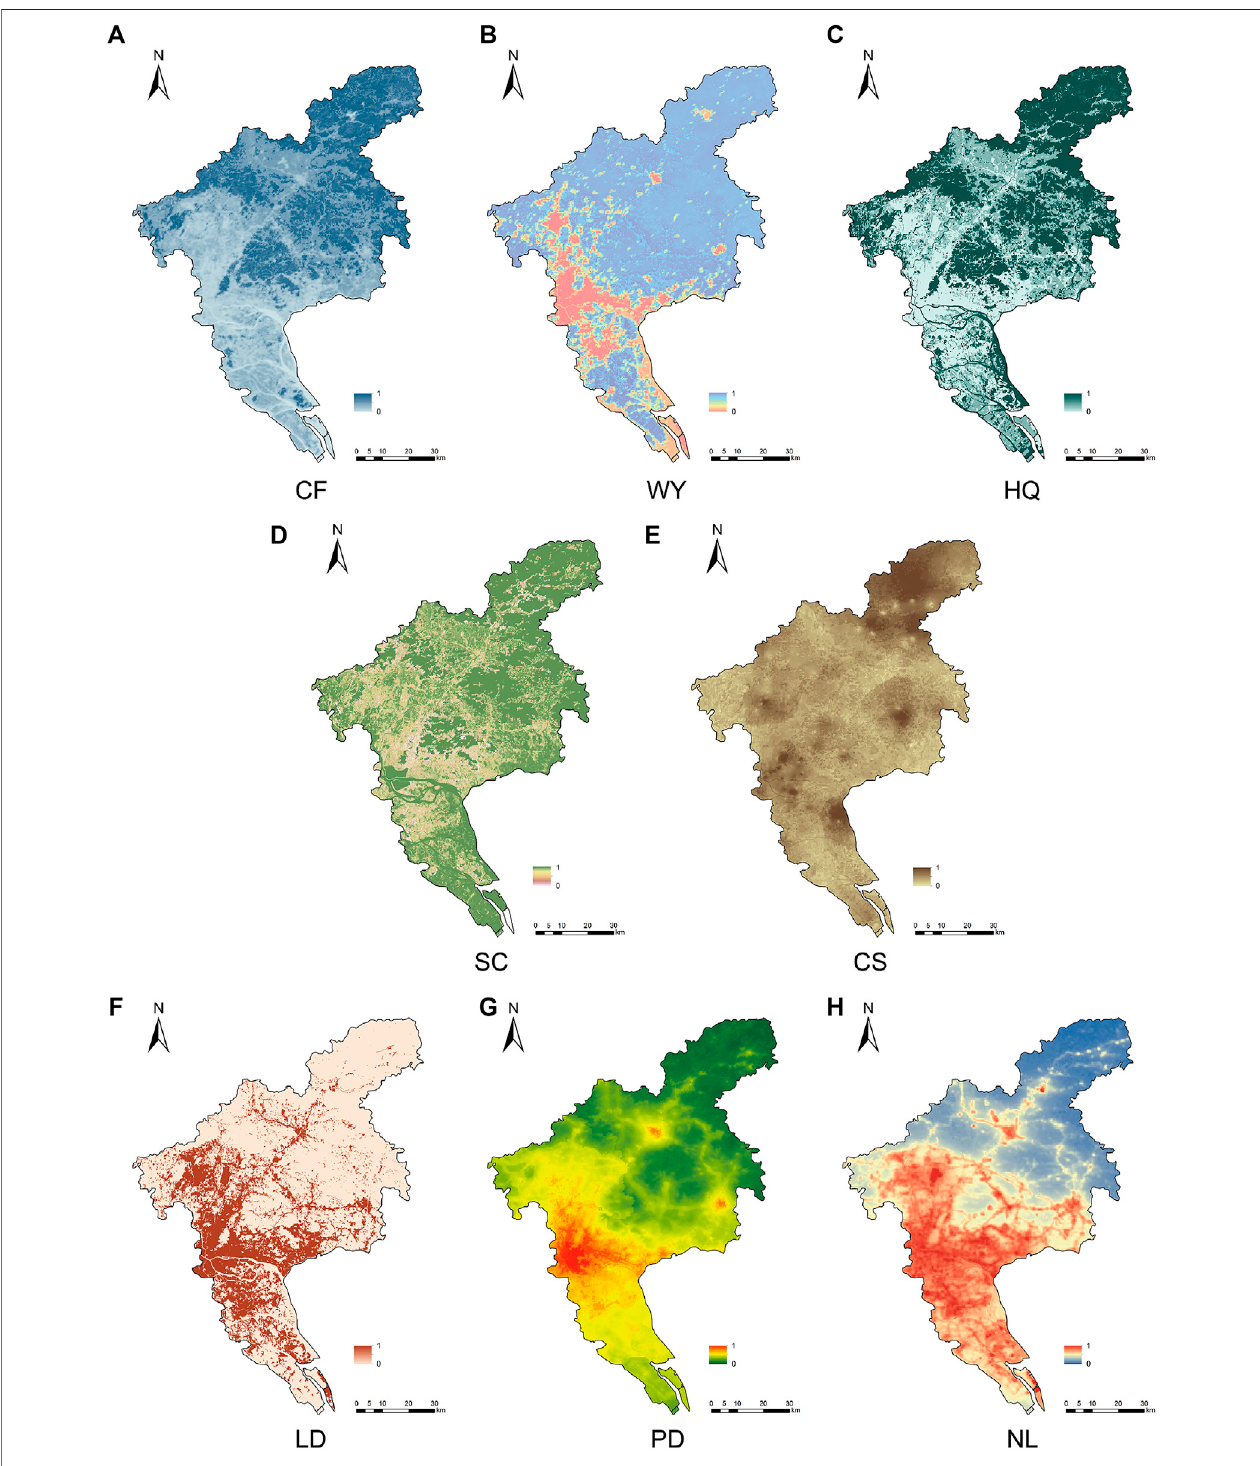
FIGURE 3 | Spatial pattern of ecosystem and socioeconomic system indicators in